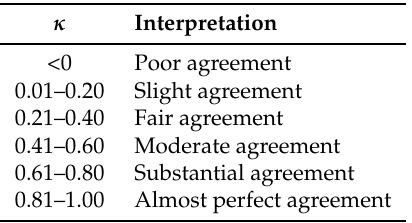
Table 14. κ interpretation table of